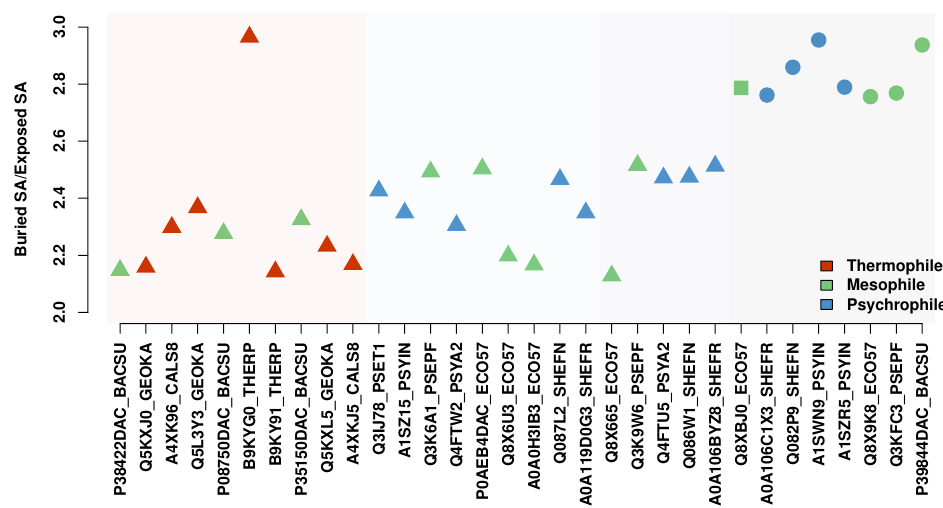
Figure 6. Ratio of external to internal surface area as a relative measure of packing, arranged by sequence similarity. In general, a greater fraction of residue surface area is buried in low-temperature proteases; a notable outlier, B9KYG0_THERP, is discussed